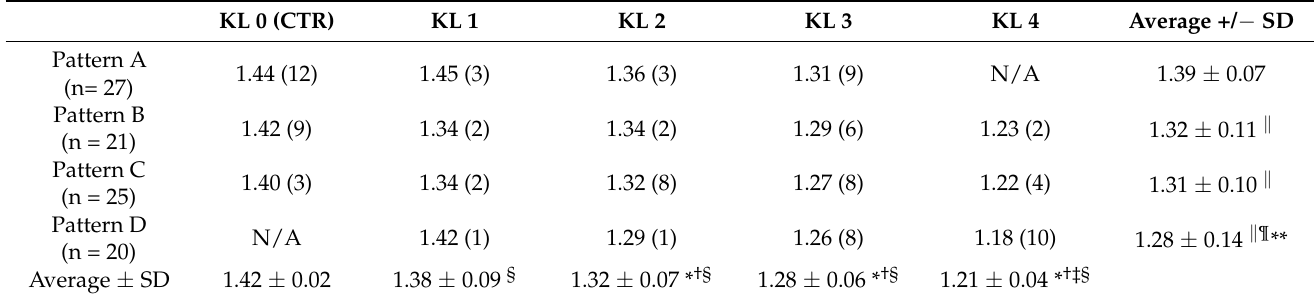
Table 2. Gait speed analysis.